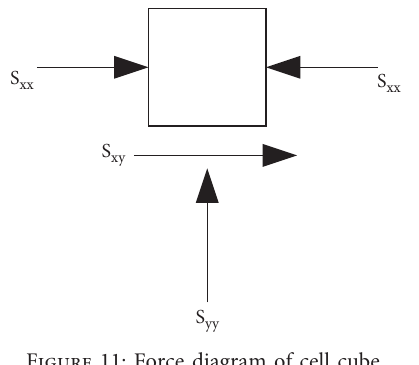
Figure 11: Force diagram of cell cube.